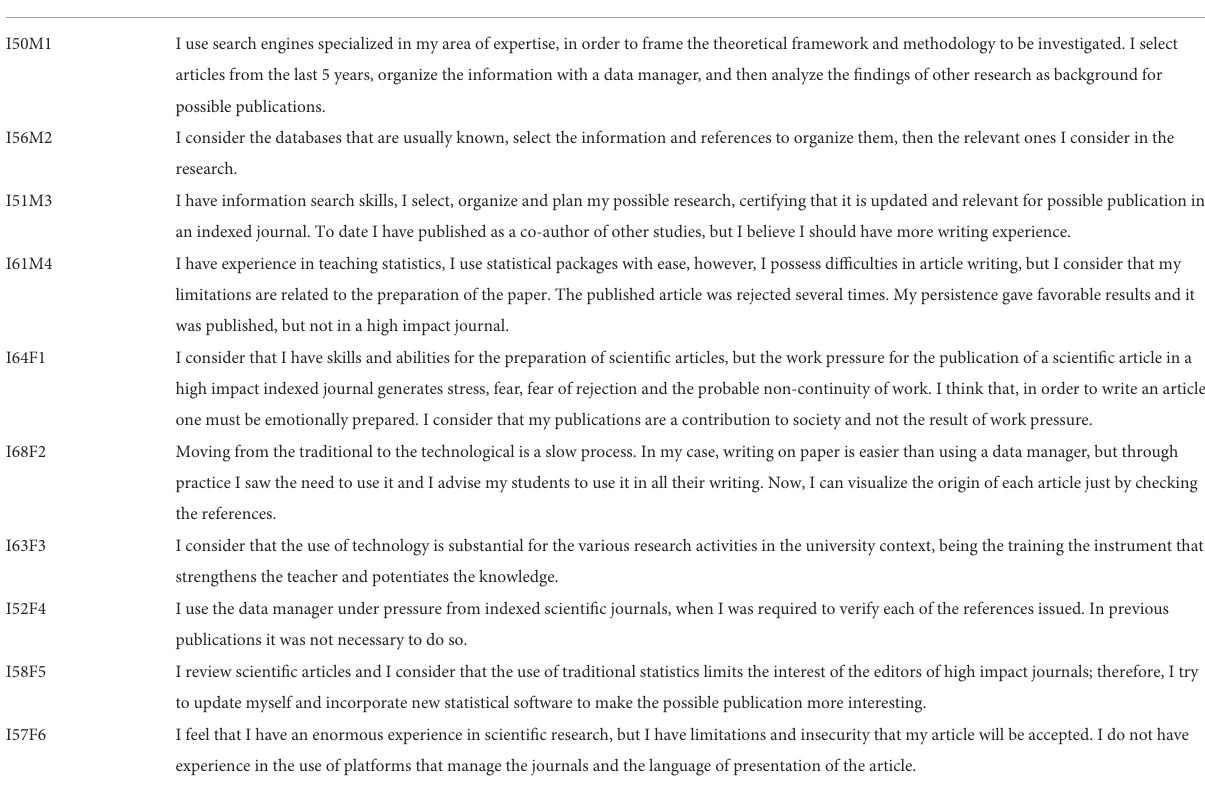
TABLE 6 Answers on technology use for each of the subjects